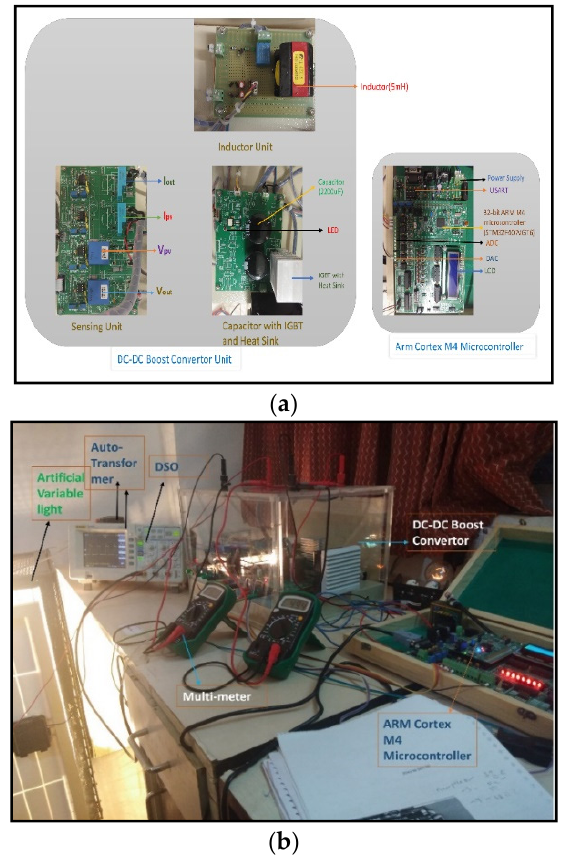
Figure 11. ( a ) Hardware components of experimental setup; ( b ): experimental set up.